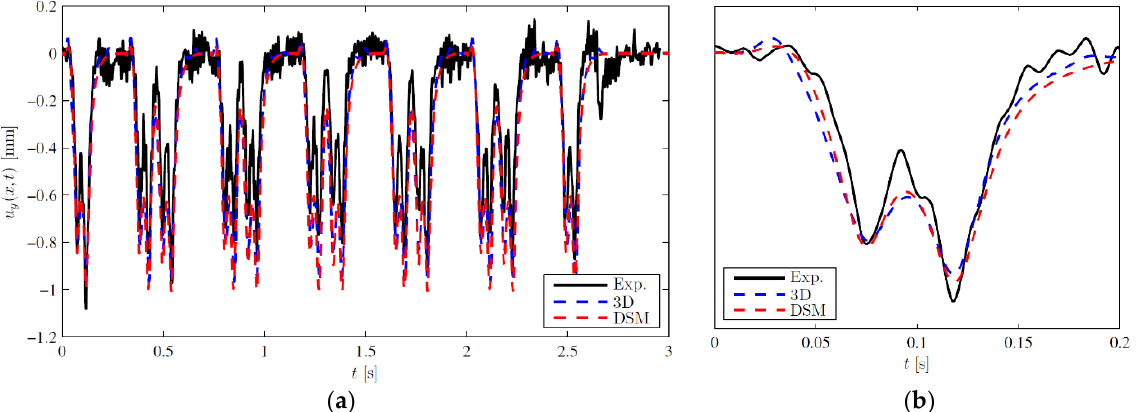
Figure 15. Vertical displacement of the rail: comparison between experimental measurements, the 3D FE model and the DSM using the mechanistic expressions; ( a ) full vehicle; ( b ) first bogie.